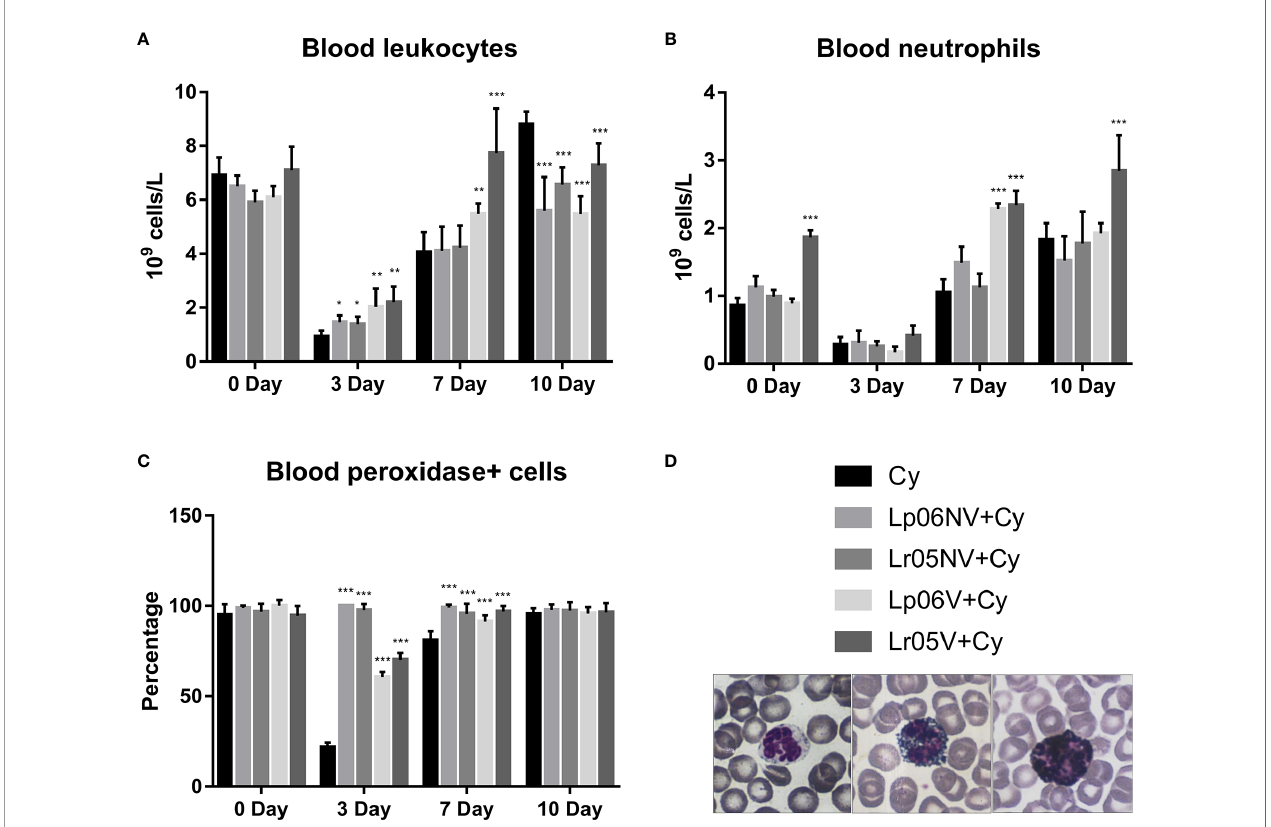
FIGURE 4 | Blood leukocytes. 6-week-old Swiss mice were fed with 10 8 cells/mouse/day of viable or non-viable Lactobacillus rhamnosus CRL1505 (Lr05V+Cy or Lr05NV+Cy groups) or L. plantarum CRL1506 (Lp06V+Cy or Lp06NV+Cy groups) for 5 consecutive days before injection of Cy. The treated groups and the untreated control mice (Cy group) received one dose of 150 mg/kg Cy intraperitoneally. Blood leukocyte (A) , neutrophils (B) , and peroxidase positive (+) cells (C) counts were performed on day 0, before Cy administration, and days 3, 7 and 10 post-Cy administration. The results come from two independent experiments. Six animals per group each time were used in the experiments. Results are expressed as mean ± SD. ***,**,* Signi fi cant differences from the Cy group should be as follows (p<0.0001, p<0.005 or p<0.05 respectively). Photomicrographs of peroxidase+ neutrophils May Grünwald Giemsa-stained blood smears (Magni fi cation X400) (D)